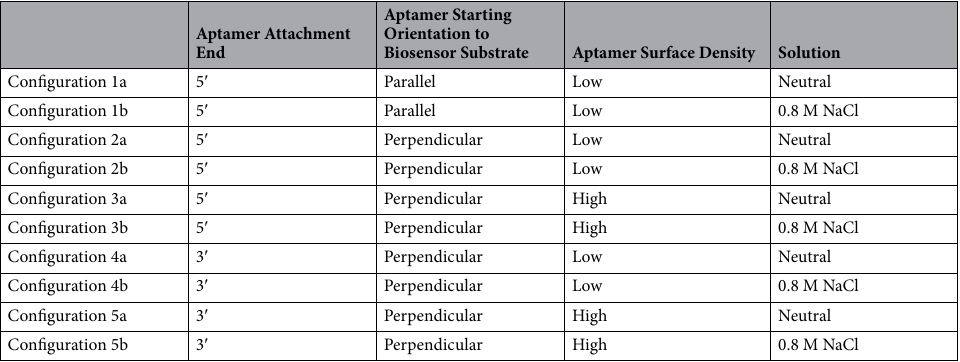
Table 1. Different anti MUC1 DNA aptamer biosensor configurations used for the MD simulation